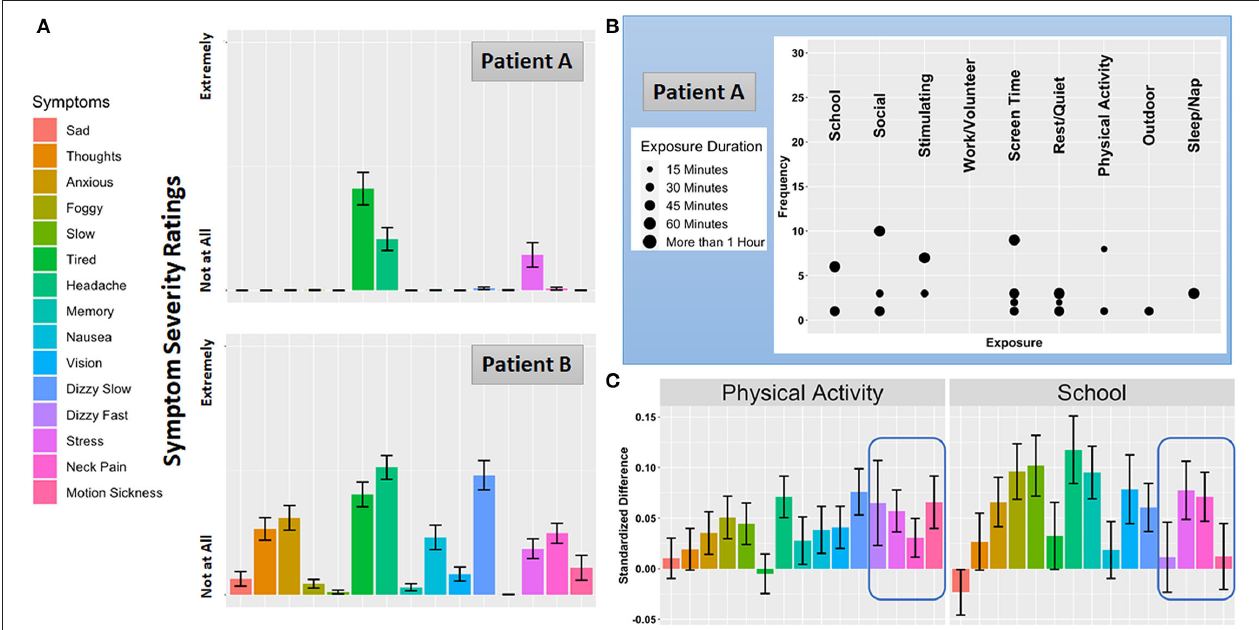
FIGURE 2 | Symptom Severity, Exposure and Activity Reports, and Context-dependent Symptom Severity Change. (A) Average symptom ratings for Patient A and Patient B over the burst. (B) Frequency and duration of the 9 everyday environments and activities Patient A reported as exposures. Consistent with the daily life a student athlete, Patient B’s exposure pattern was very similar to Patient A and not displayed here. (C) Exposure-specific symptom reactivity to two common everyday exposures for participants enrolled in the MNCH